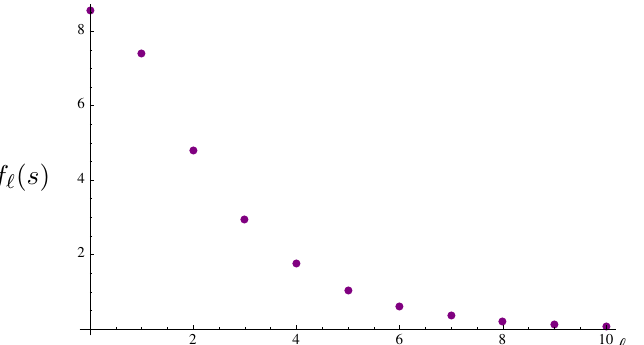
Figure 22 . We plot the coefficients f ‘ ( s ) for s = 14 . We see that the coefficients are suppressed for higher spins.